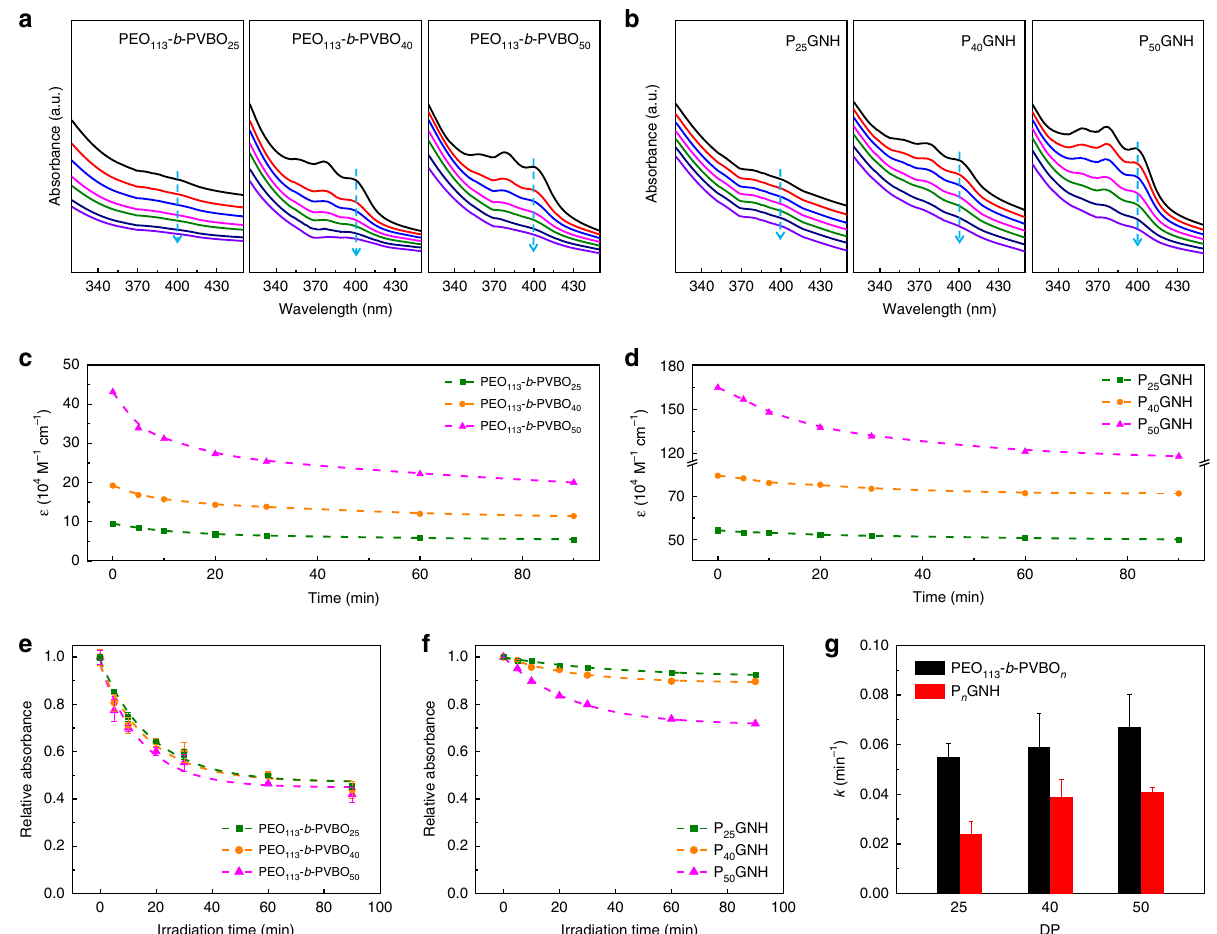
Fig. 3 Photoisomerization behavior under UV/visible illumination. UV – visible absorption spectra of aqueous dispersions of ( a ) PEO 113 - b -PVBO n and ( b ) P n GNH under UV irradiation for 90 min (recorded at 0, 5, 10, 20, 30, 60, and 90 min). Molar extinction coef fi cients at 400 nm as a function of irradiation time for ( c ) PEO 113 - b -PVBO n and ( d ) P n GNH. Relative absorbance [ A ( t )/ A 0 ] of the major peak at 400 nm as a function of irradiation time, where the absorbance A was divided by the initial value A 0 , for ( e ) PEO 113 - b -PVBO n and ( f ) P n GNH. g Calculated rate constants (with s.d. error bars) for different